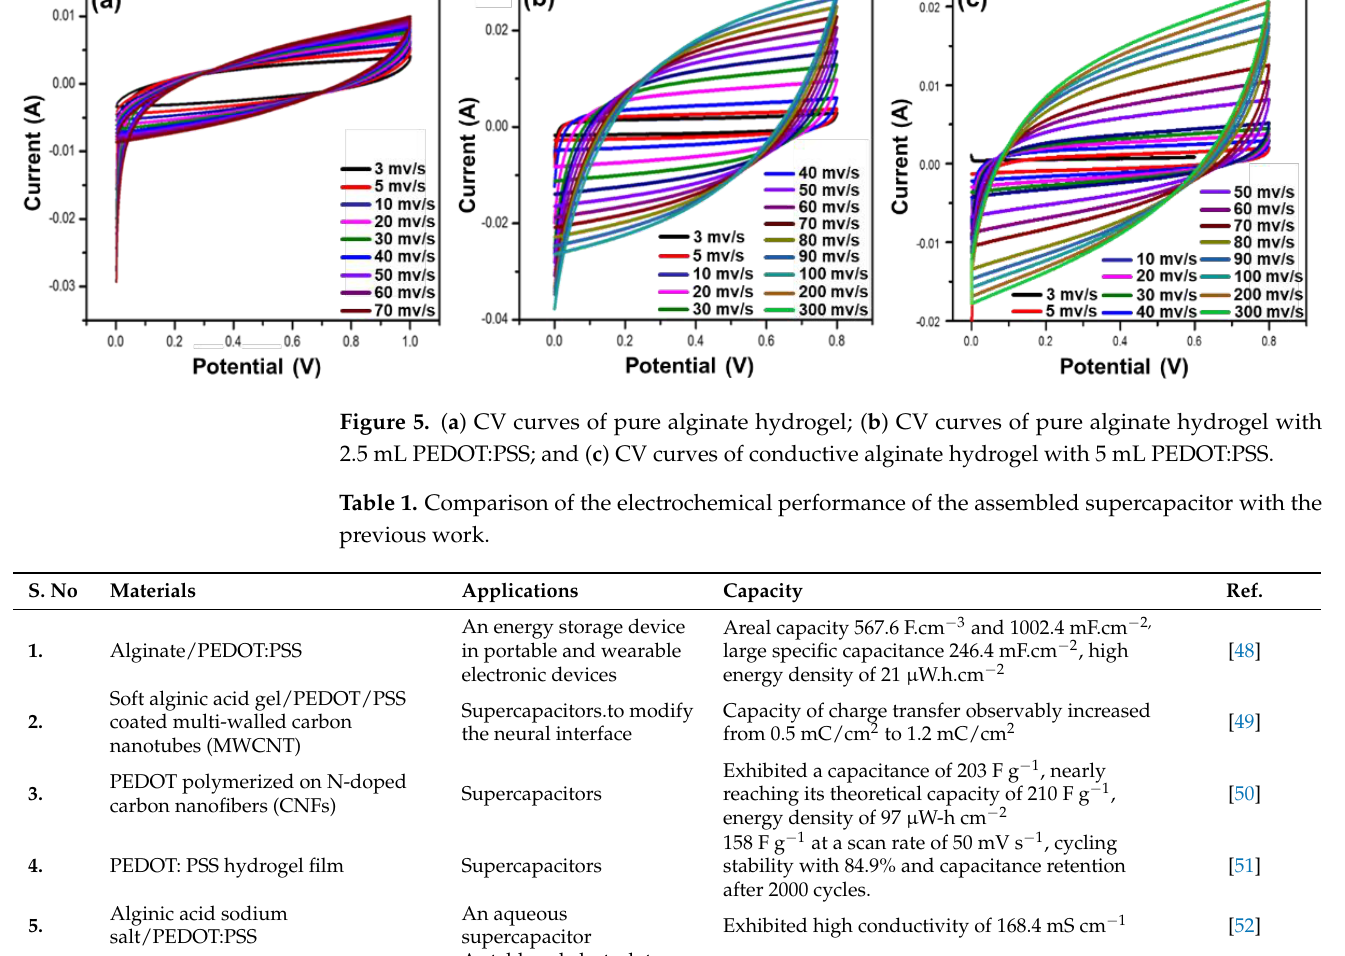
stability with 84.9% and capacitance retention after 2000